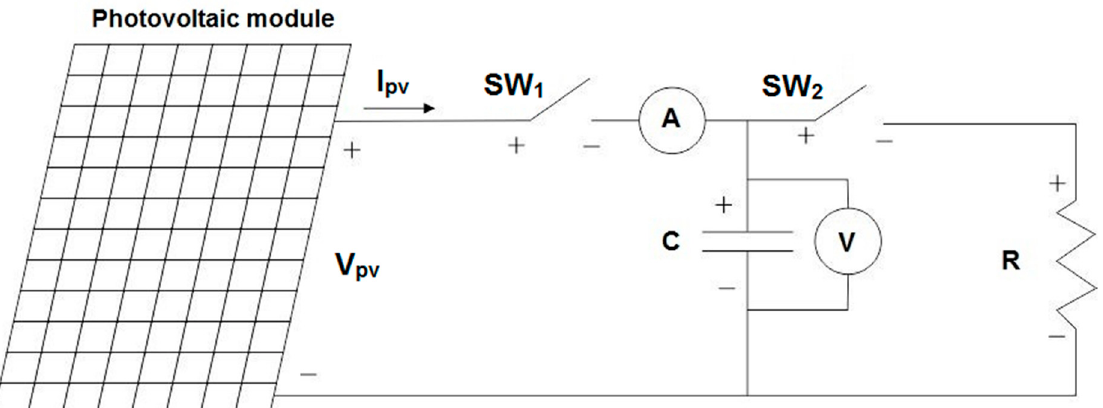
Figure 2. PV Module I-V curve extraction circuit. I pv : PV module current, V pv : PV Module voltage, SW 1 : Load capacitor switch 1, SW 2 : Load resistor switch 2, A: Oscilloscope Current sensing probe, V: Oscilloscope voltage sensing probe, C: Capacitor load, R: Resistor load.